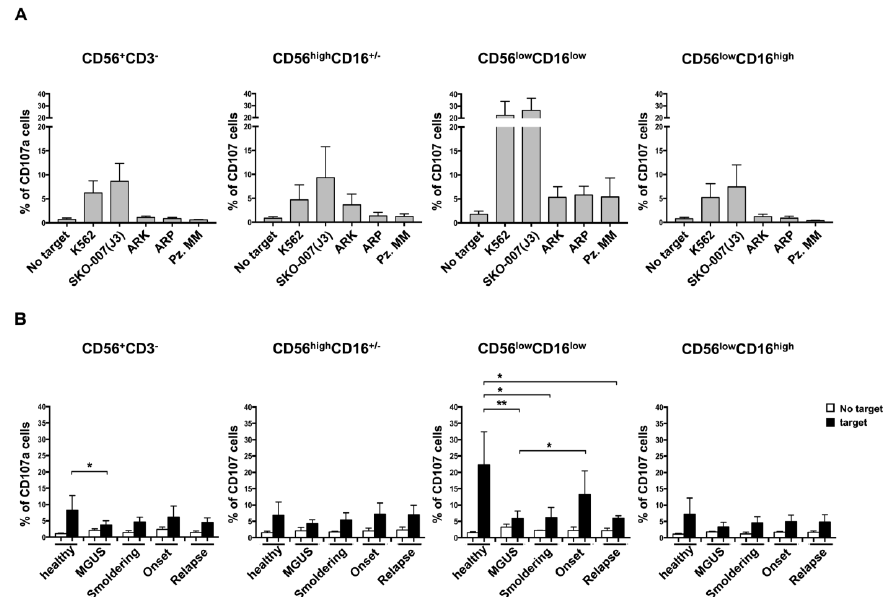
Figure 3. NK cell subset degranulation in MM patients. PBMCs derived from healthy donors were incubated for two hours with distinct targets as indicated, the K562 cell line, three MM cell lines (i.e., SKO-00(J3), ARP and ARK) and primary malignant plasma cells (PCs). Cells were harvested and stained with anti-CD3, anti-CD56, anti-CD16 and anti-CD107 antibodies. Values corresponded to the mean +/−SD of the percentage of CD107 + cells of at least three experiments are shown ( A ). Degranulation assay performed as described in panel A using PBMCs derived from patients at different state disease as indicated. Values are expressed as mean percentage of CD107 + cells and error bars represent SD ( B ). ** p < 0.01; * p < 0.05. Healthy donors, n = 6; MGUS, n = 6; Smoldering, n = 4; Onset, n = 5; Relapse, n = 4).